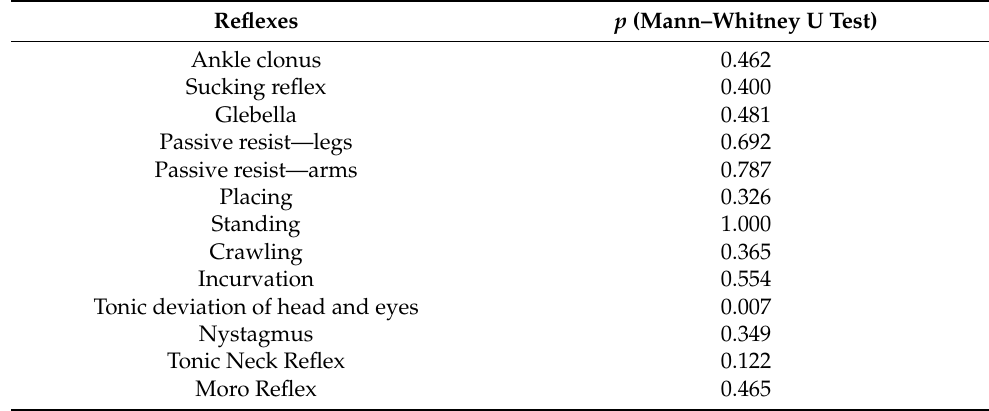
Table 1. Differences in assessed reflexes between premature and full-term infants (before and after 37 weeks of